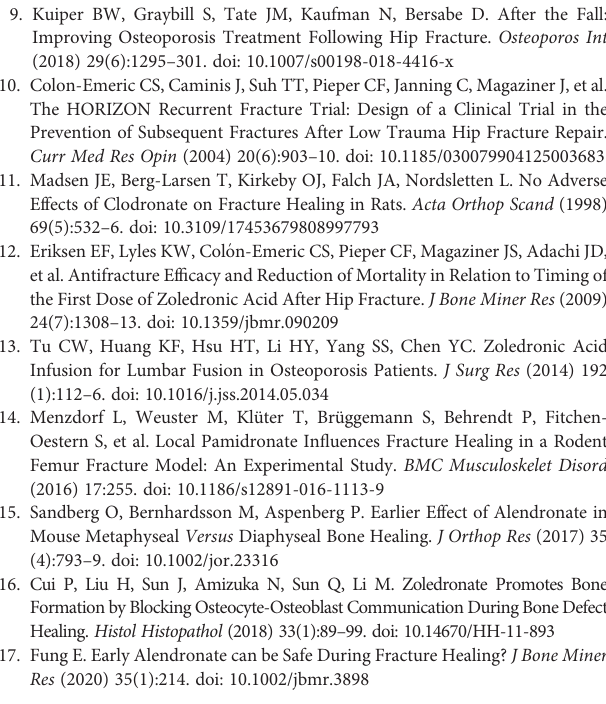
Supplementary Figure 1 | Funnel plot of BMD changes with Reid, I. R. 2013 deleted. Supplementary Figure 2 | subsequent subgroup analysis of Fracture Healing